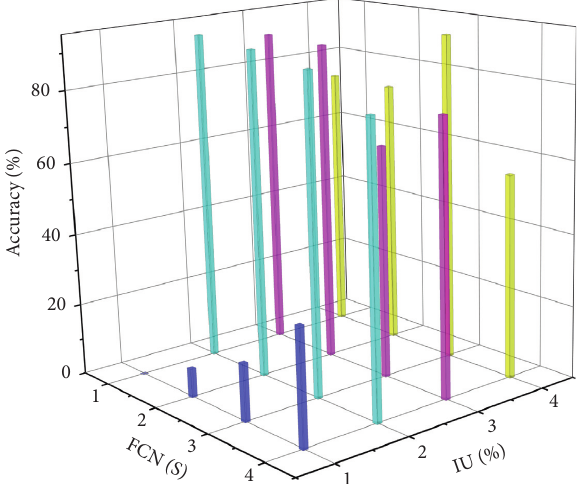
Figure 7: The results of three up-sampling semantic segmentation on landscape images.